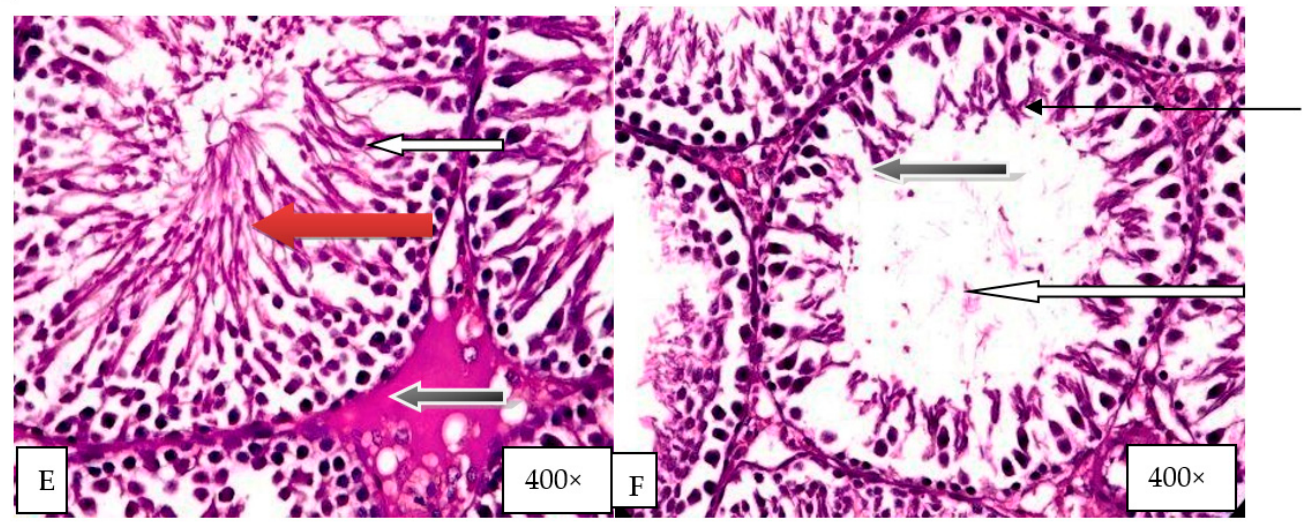
Figure 6. Histological evaluation of the effect of graded doses of HELEPN on the testis. Group ( A ) (control), Group ( B ) ( D -galactose), Group ( C ) (250 mg/kg HELEPN), Group ( D ) (500 mg/kg HELEPN), Group ( E ) ( D -galactose and 250 mg/kg HELEPN), Group ( F ) ( D -galactose and 500 mg/kg HELEPN).